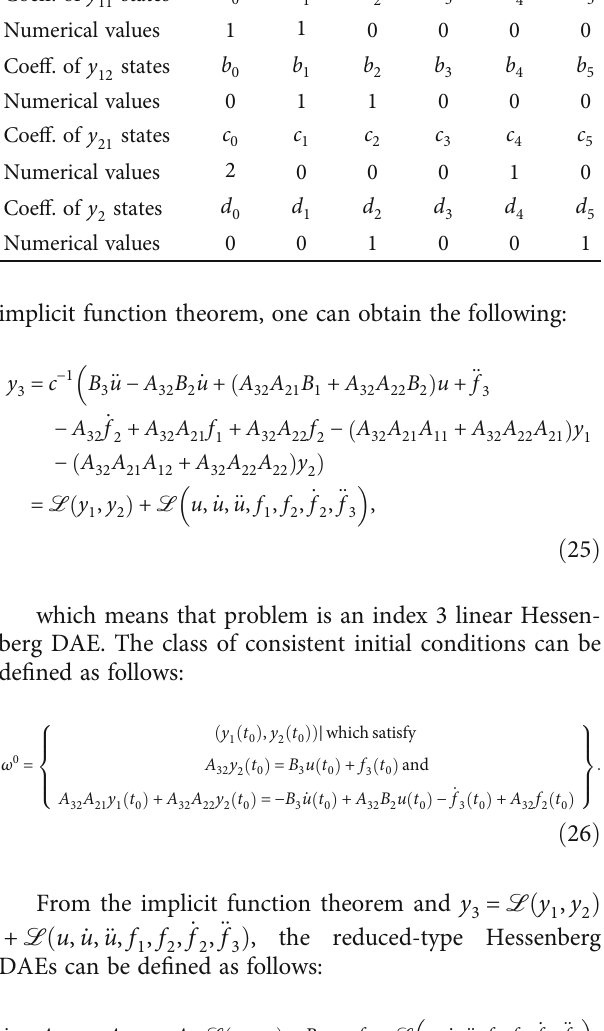
Table 1: Unknown coe ffi cients of the representation of y